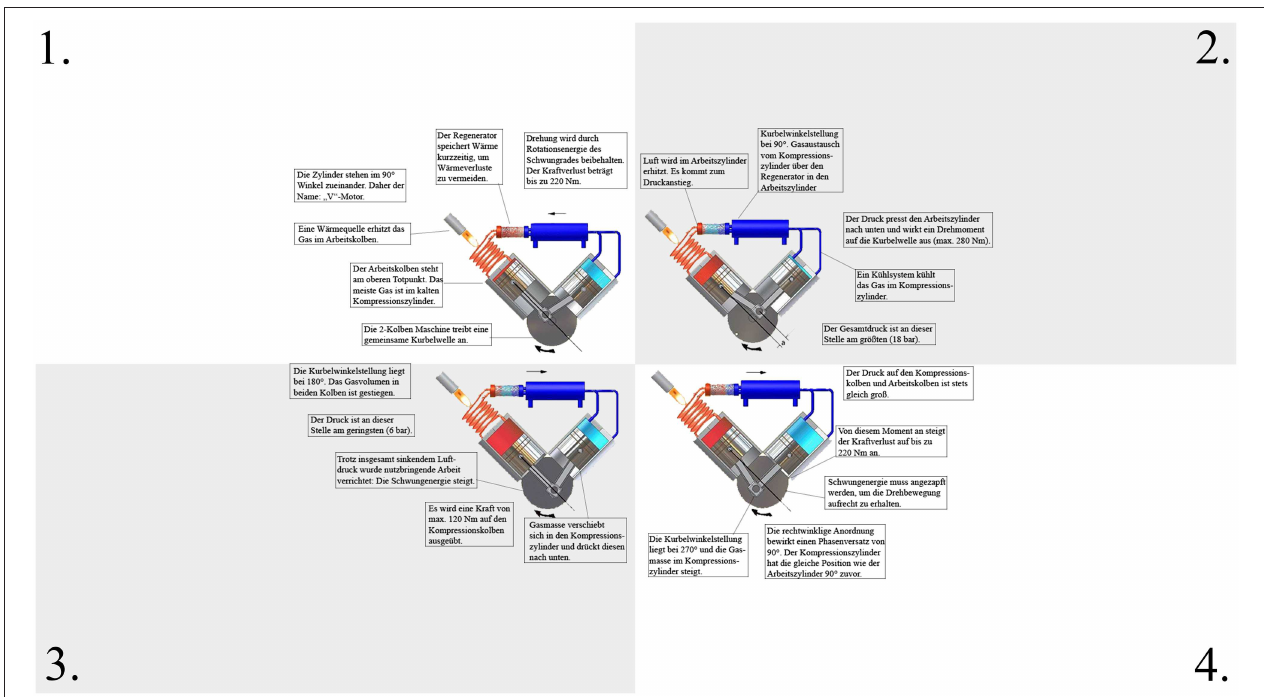
FIGURE 6 | Integrated text-picture presentation with high spatial proximity in Experiment 2.